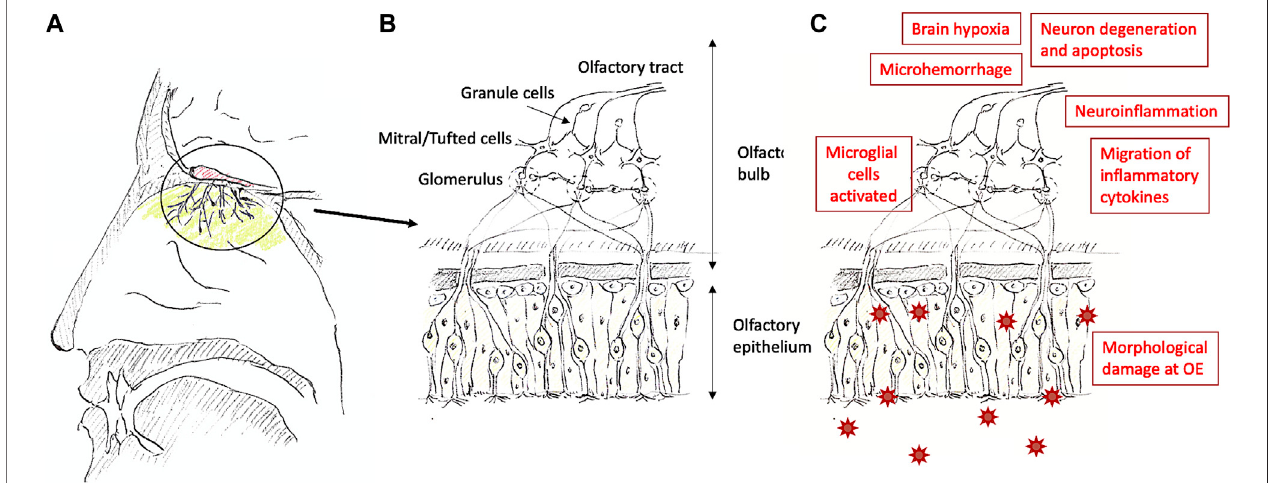
FIGURE 1 | Nose (A) , a summary of the olfactory system (B) , and possible causations causing olfactory dysfunction (C) . The olfactory epithelium is located at the upperendinthenasalcavity[coloredwithlightgreenin (A) ],andtheolfactorybulbislocatedabovethearea[coloredinredin (A) ].Thestructureoftheolfactoryepithelium toward the olfactory bulb [the circled area is shown in (A) ] is shown in (B) . At the olfactory epithelium, there are supporting cells [rather square-ish cells without axons extendingtotheolfactorybulbin (B) ],Bowman ’ sglands[notdrawnin (B) ],andbasalcells[roundcellsin (B) ]otherthantheolfactorysensoryneurons[cellswithcilia and extending axons toward the olfactory bulb in (B) ]. SARS-CoV-2 enters the supporting cells through ACE2 and cause morphological damage, in fl ammation, and further migrates to the brain (Meinhardt et al., 2020). Olfactory dysfunction can be caused by multiple factors as shown in (C)